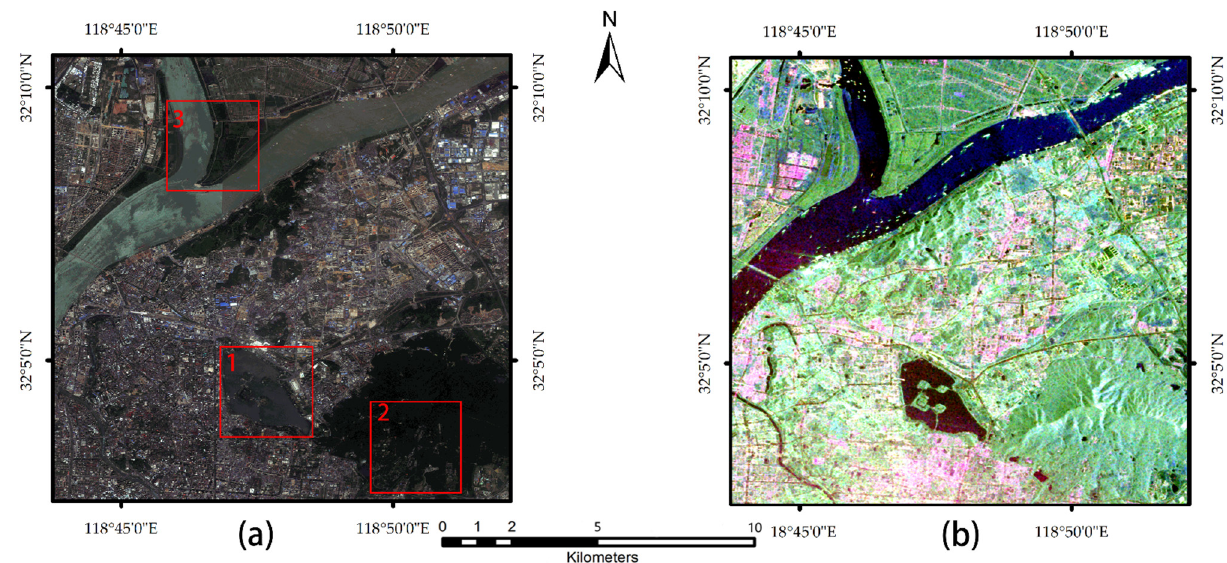
Figure 1. Study area. ( a ) The optical image. ( b ) The polarized SAR false-colour image.